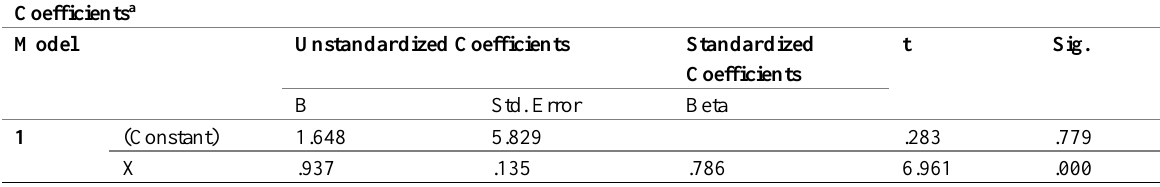
Table 4: Simple Linear Regression